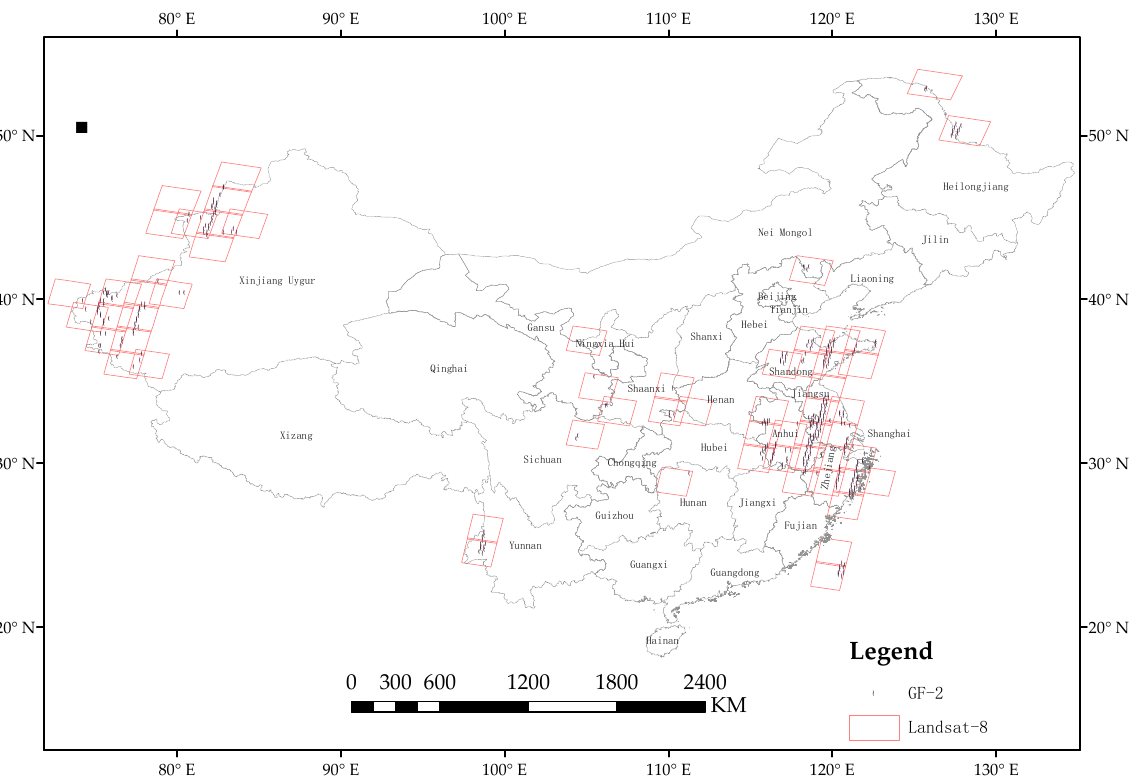
Figure 5. Map of the GF-2 scenes (purple dots) corresponding to the paired Landsat-8 scenes (red quadrangles) for cross-comparison over China and adjacent regions. (1) GF-2 3.2 m LSR spatial aggregation to 30 m resolution. Firstly, the GF-2 pixels were spatially aggregated into Landsat 30 m spatial resolution to ensure the pixel-to-pixel comparison. Then, the following criteria were applied to select the valid GF-2 pixels: (i) cloud and cloud-shadow free pixels, (ii) snow- and water-free pixels, and (iii) saturation-free pixels. Landsat pixels comprising less than 100% valid GF-2 pixels were excluded from the analysis. The valid Landsat pixels were selected by the quality assessment files (i.e., * .QA_pixel.tif and *